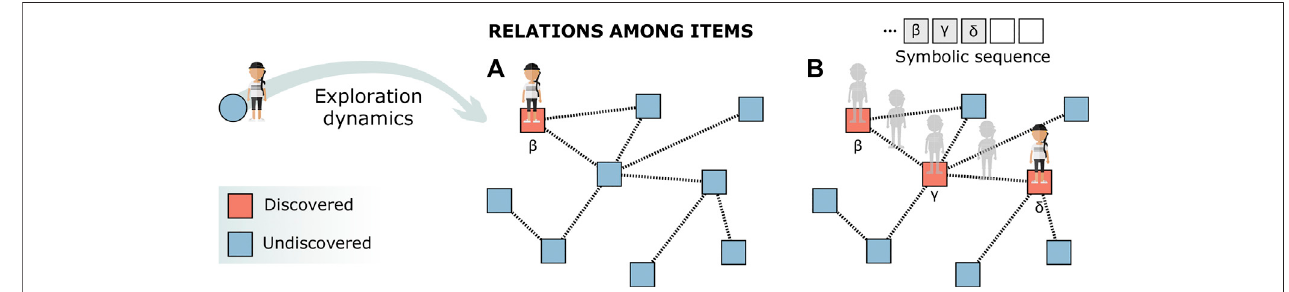
FIGURE 2 | Illustration of an exploration process. The cognitive process through which an individual agent explores the space of possibilities in search of novel items (novel ideas and technological discoveries) is usually modeled as a walk over a network of relations (similarities or proximity) among items. For example, in (A) , the agentdiscoversitem β andthencontinuestheexplorationoverthelinksofthenetworkbysequentiallymovingtonode γ andthentonode δ .In (B) ,threeitemshavebeen discovered, and the exploratory walk can be seen as a sequence of symbols representing the visited nodes.